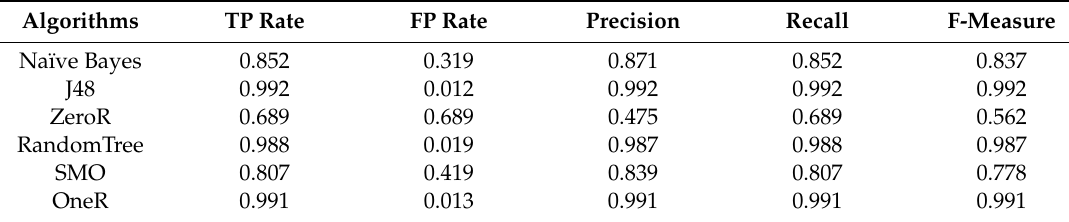
Table 6. Values of TP, FP, precision, recall, and F-measure for algorithms.